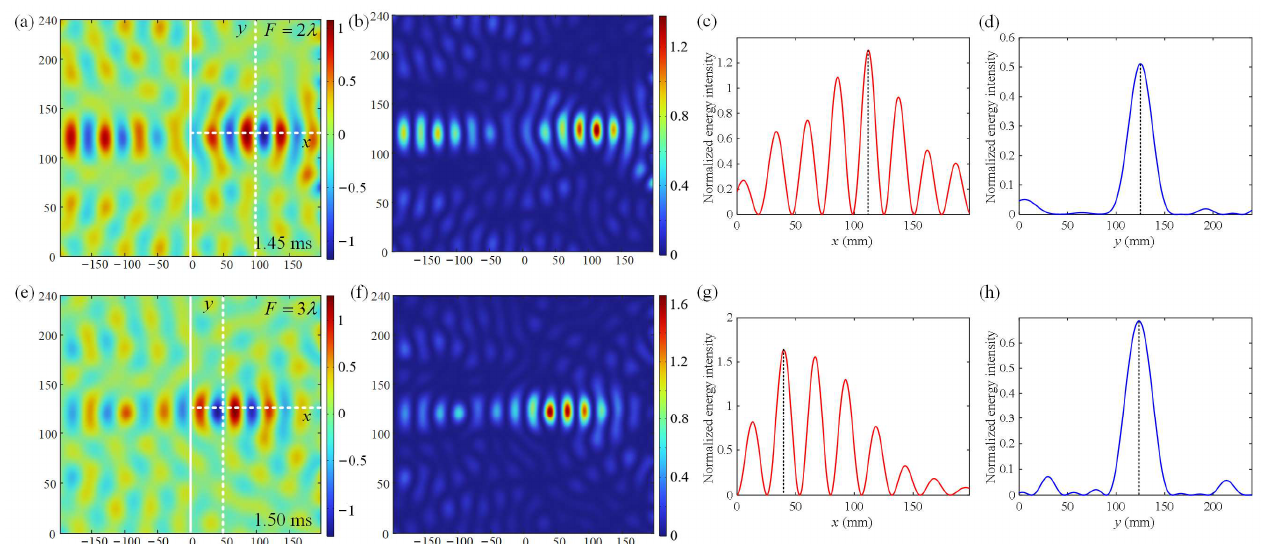
Figure 9. Numerical simulation results of ( a ) the reflected flexural wave field, ( b ) the normalized energy intensity field, and ( c , d ) the corresponding normalized energy intensity distribution along the white dashed line when the focal distance is 2 λ . Numerical simulation results of ( e ) the reflected flexural wave field, ( f ) the normalized energy intensity field, and ( g , h ) the corresponding normalized energy intensity distribution along the white dashed line when the focal distance is 3 λ .